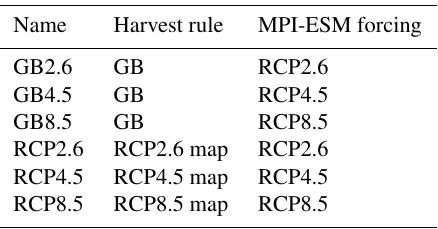
Table 1. JSBACH simulations conducted in this study with the ap- plied harvesting rule and climate and CO 2 forcing. GB denotes the growth-based rule and RCP denotes the Representative Concentra- tion